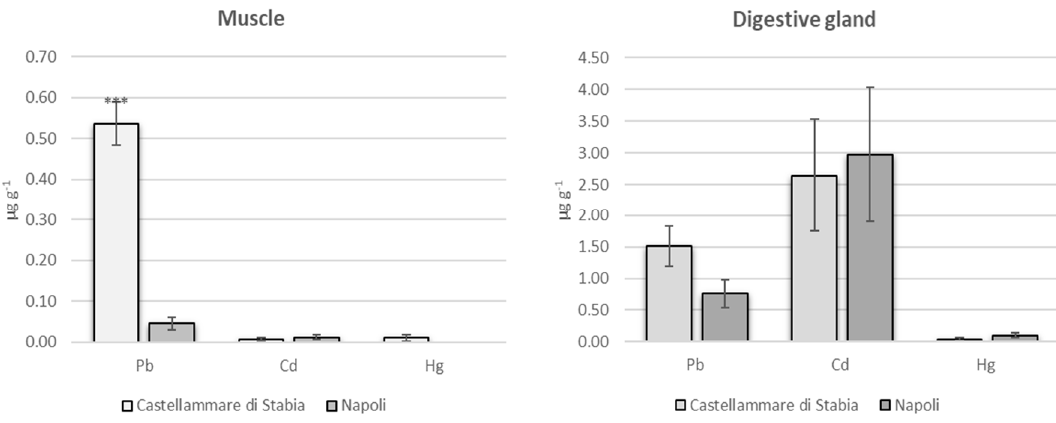
Figure 1. Mean concentration ( µ g g − 1 wet weigth) ± SEM of Pb, Cd and Hg in O. vulgaris muscle and digestive gland from Napoli and Castellammare di Stabia. Probability levels for significant differences from sampling sites: p < 0.001(***); p < 0.01 (**); p < 0.05 (*).